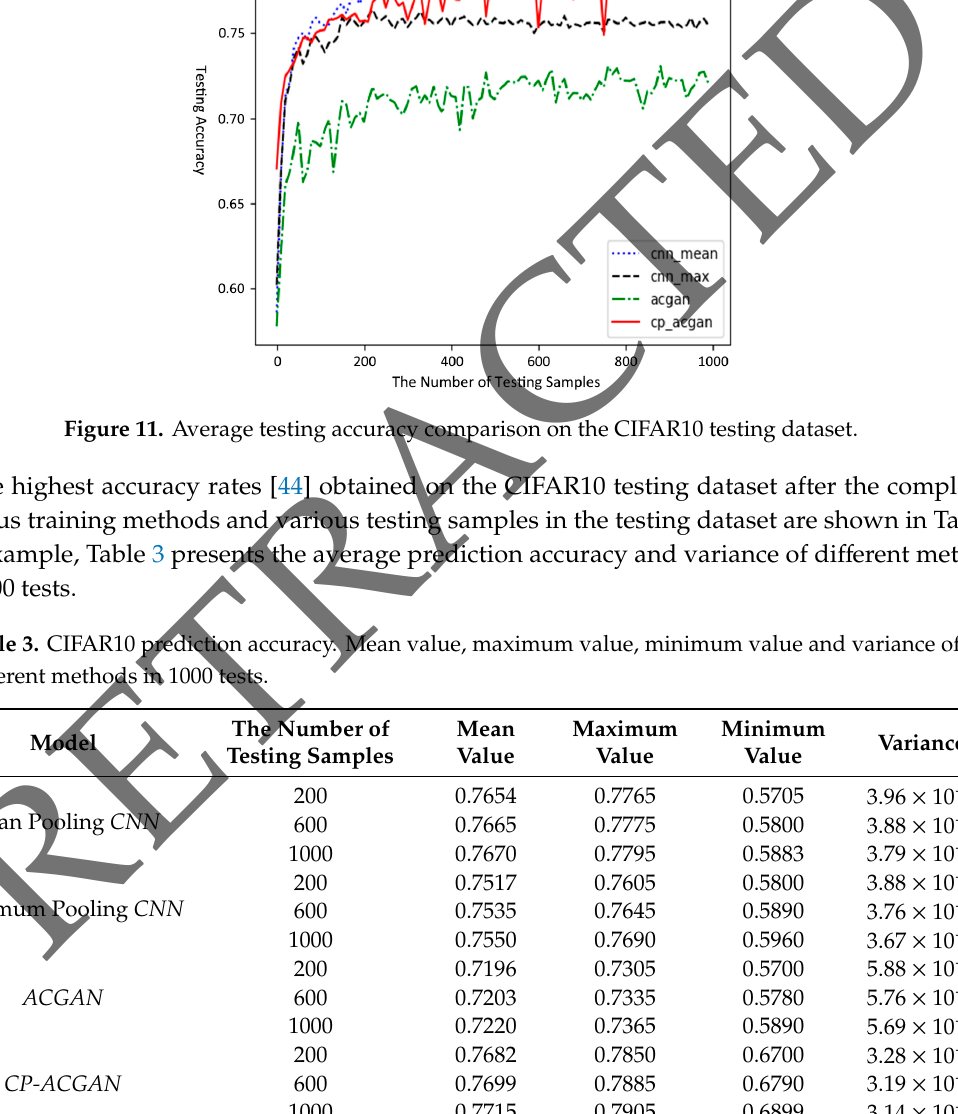
Figure 10. Average classification accuracy of different methods on the CIFAR10 training dataset.